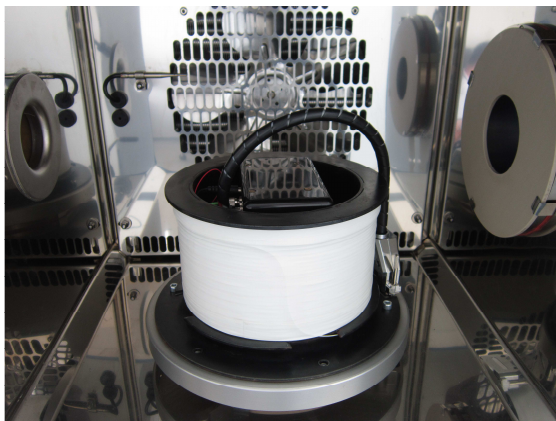
Figure 8. The experimental I-FOG setup tested on an RMS SDL1401 rotary table in a CTS T-65/50 temperature